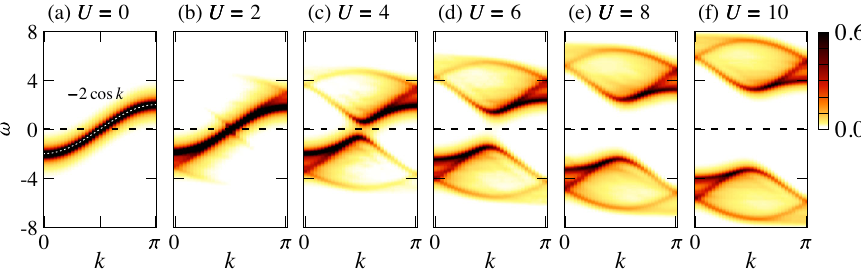
FIG. 4. Mott transition calculated from dVMC with 64 sites on the 1D Hubbard model at half-filling. Different panels show different interaction strengths U